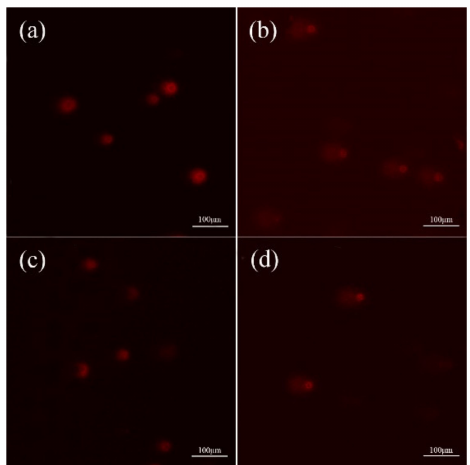
Figure 3. Comet assay of DNA from colon epithelial cells exposed to BaP treatments. A propidium iodide (PI) stain was done, and the images were captured under an epifluorescence microscope with a scale bar of 100 µ m. ( a ) control group; ( b ) BaP treatment; ( c ) strain BI-04 group; ( d ) strain BI-04 + BaP treatment. Table 2. DNA damage of colon epithelial cells induced by various BaP treatments. DNA Damage Indicators Groups Comet Length Tail Length Tail Moment OliveTail Moment